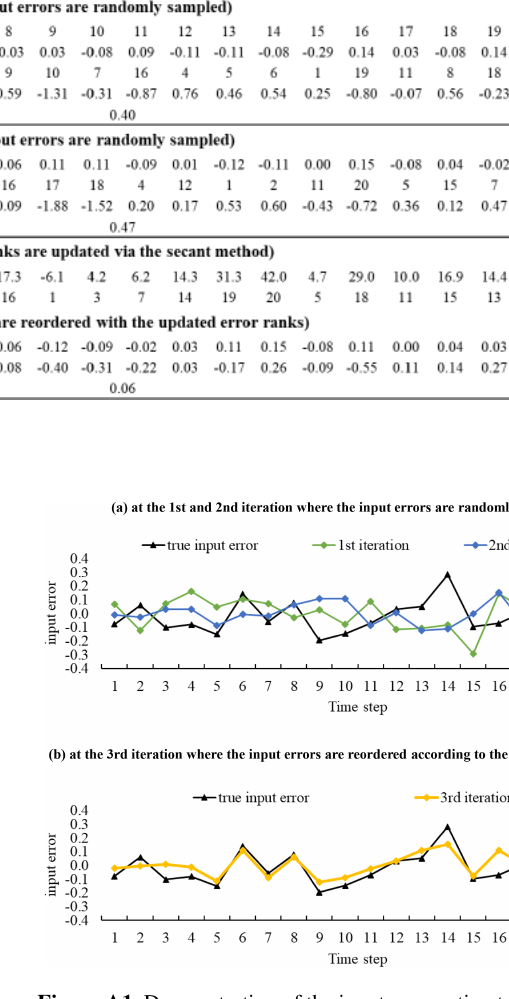
Figure A1. Demonstration of the input error estimated in Table